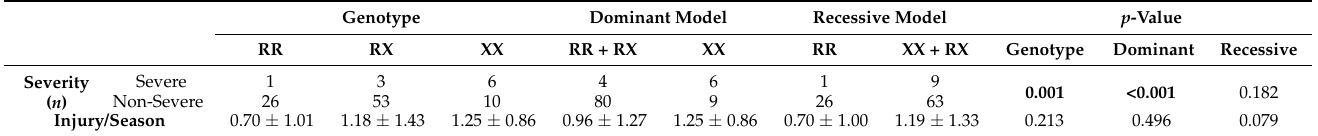
Table 3. Association between the ACTN3 R577X genotypes and severity and incidence of non-contact muscle injury (per season). The differences between the groups regarding severity were evaluated with the χ 2 test, and the differences in injury per season were evaluated with one-way ANOVA. Bold emphasizes values of p < 0.05.